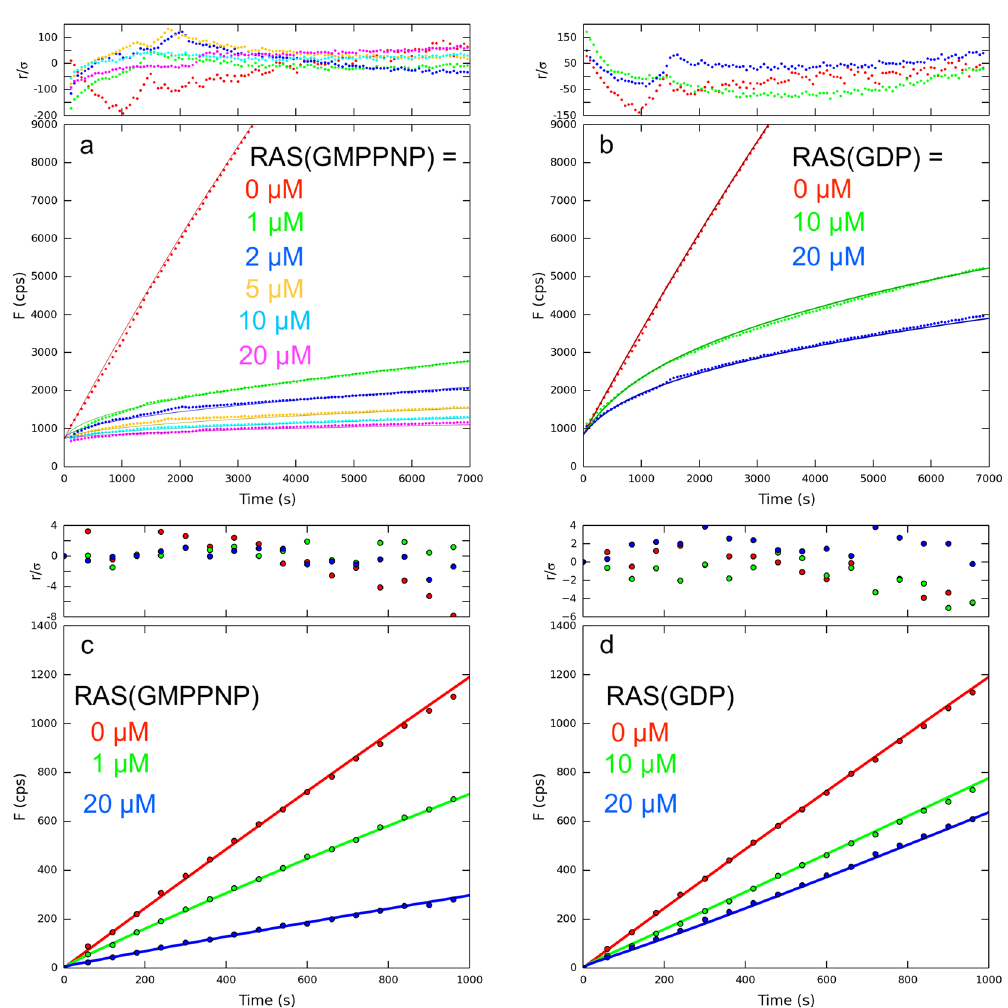
Fig. 6 Kinetics of AMC release from QEEYSAM-AMC by 100 nM RASProtease in the presence of RAS. a RASProtease(I) + RAS(GMPPNP). b RASProtease(I) + RAS(GDP). ( a ) and ( b ) were measured in the presence of 1 µ M QEEYSAM-AMC and 1 mM imidazole. c RASProtease(N) + RAS (GMPPNP). d RASProtease(N) + RAS(GDP). ( c ) and ( d ) were measured in the presence of 1 µ M QEEYSAM-AMC and 1 mM nitrite. Data points are solid circles. Global fi t to mechanism 1 are solid lines. Residuals are plotted above each